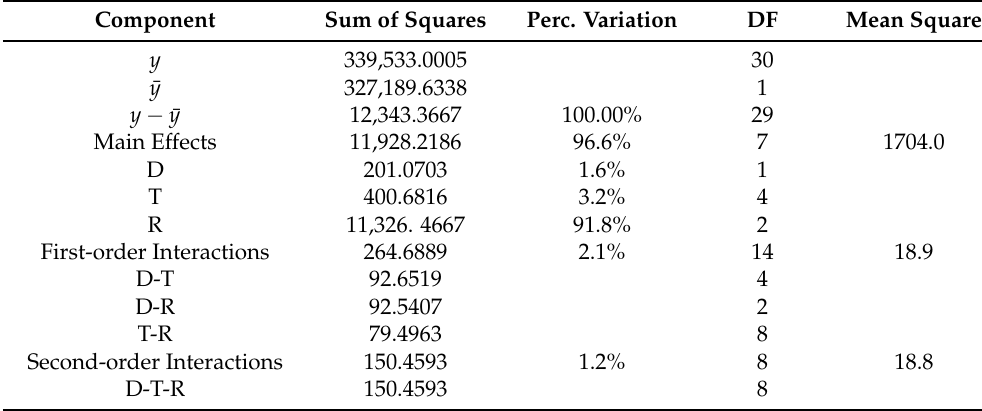
Table 8. ANOVA of trip